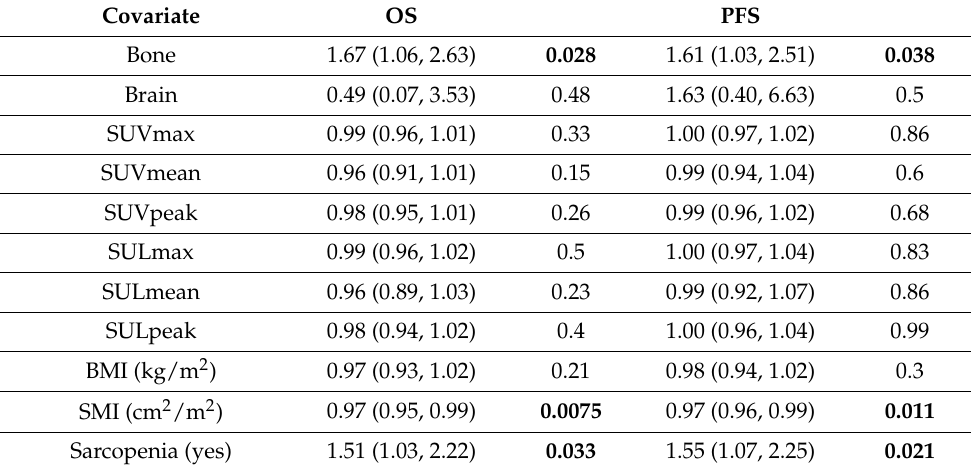
Figure 3. Time-dependent AUC for PFS. Clinical variables include ECOG performance status and bone metastases.